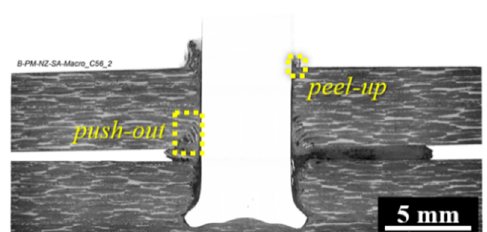
Figure 7. Typical cross-section of a Ti6Al4V/carbon fiber-reinforced polyether-ether-ketone (CF-PEEK) friction-riveted joint produced without the application of external clamping pressure. (Joining parameters: RS: 15,000 rpm, FF: 15 kN, DF: 7.5 mm).